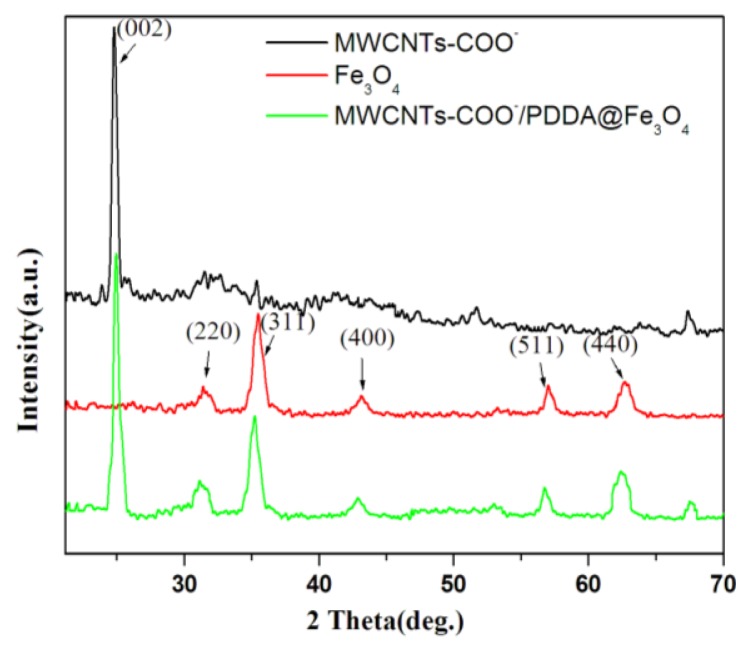
X-ray diffraction (XRD) patterns of MWCNTs-COO−, Fe3O4 and MWCNTs- COO−/PDDA@ Fe3O4.